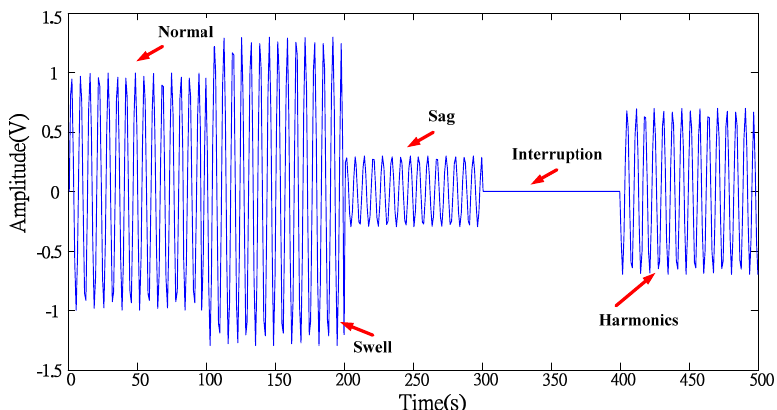
Figure 6. Simulated power system signal with various